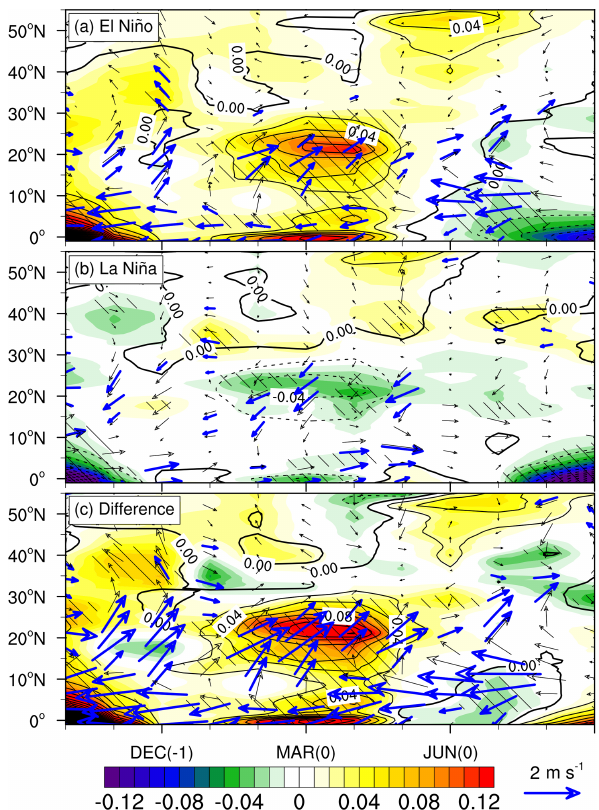
Figure 7. Latitude–time cross-sections of composite anomalies of AOD (shading), AOD of CAs (black contour with interval of 0.02), and 850hPa wind (vector; ms − 1 ) during (a) El Niño and (b) La Niña and (c) their difference (El Niño minus La Niña) averaged over 100–120 ◦ E. Hatching and blue vectors indicating the anomalies of AOD and winds are statistically significant at the 95% confidence level based on the Student’s t test,